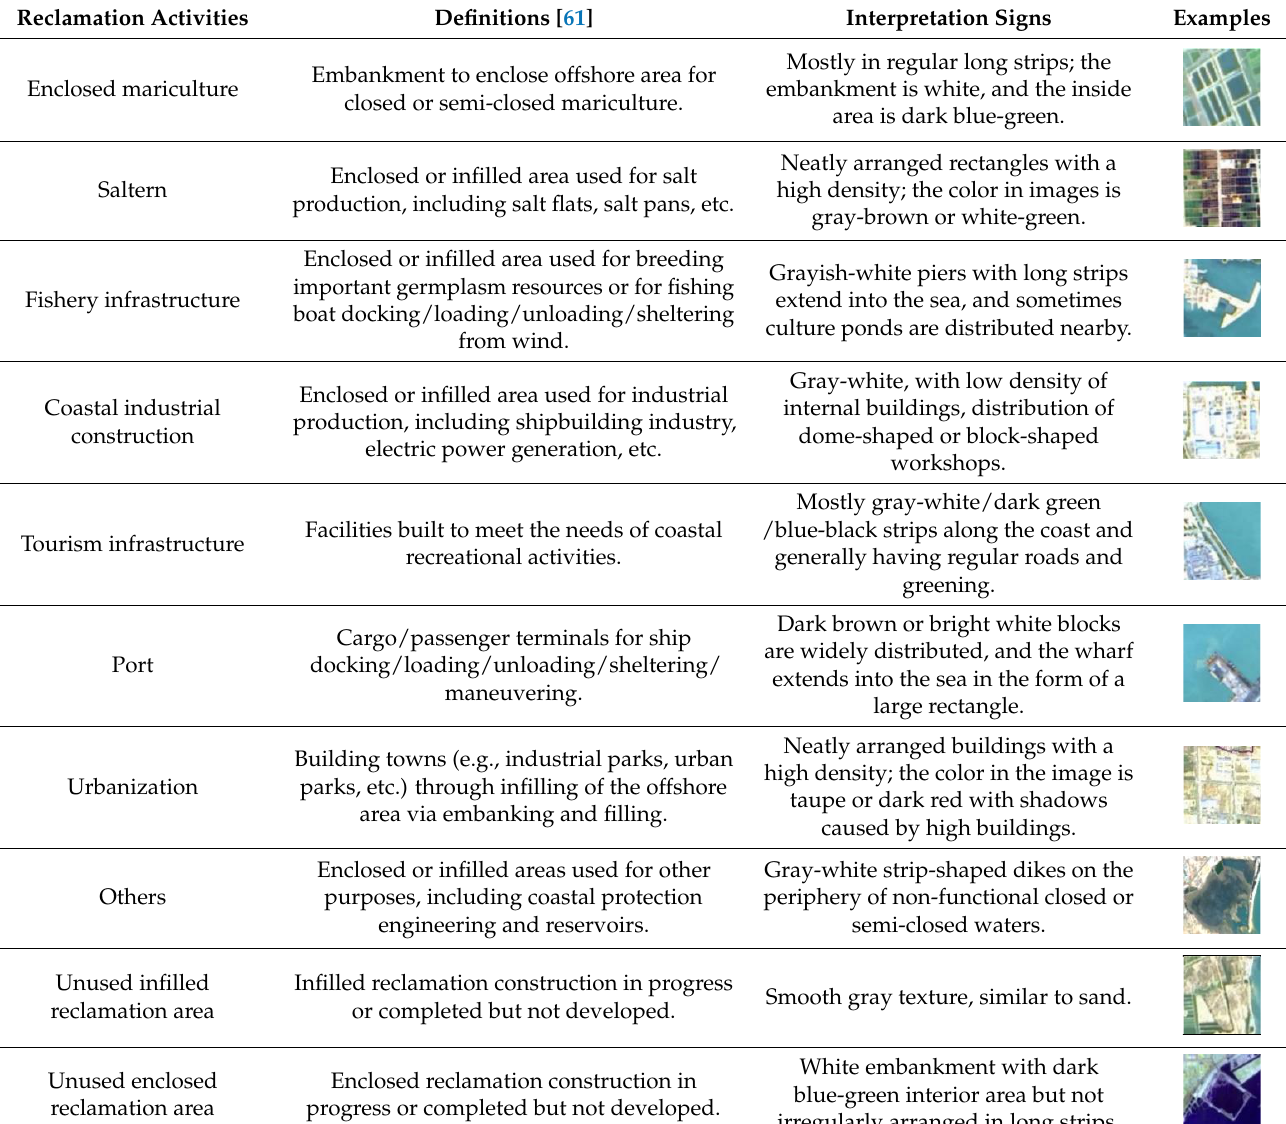
White embankment with dark blue-green inte- rior area but not irregularly arranged in long